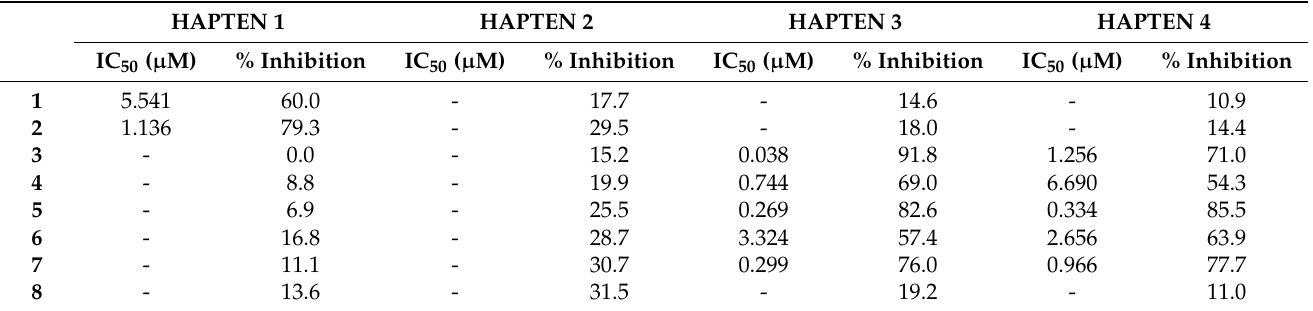
Table 1. IC 50 and % inhibition (10 µ M) values of each hapten against our SCRA